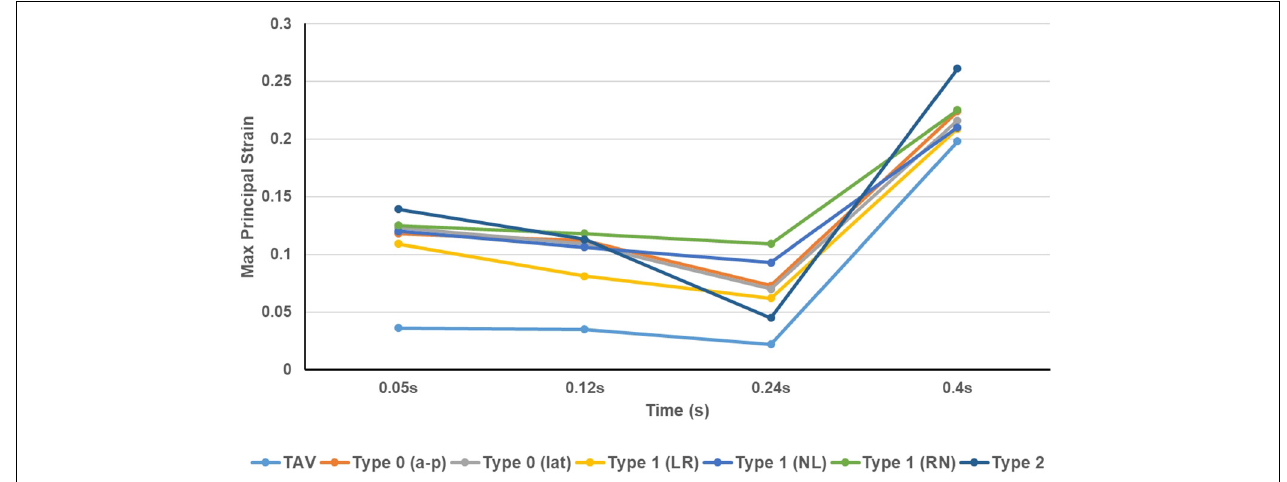
FIGURE 9 | The peak value of maximum principal strain of TAV and BAV models at different moments ( t = 0.05, 0.12, 0.24, 0.4